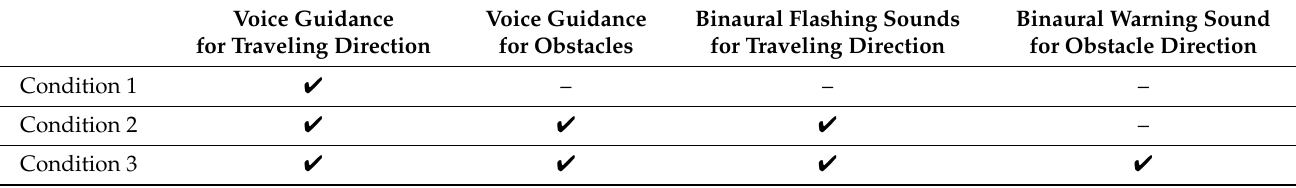
Table 9. Voice information on the direction in which to move at each of the junctions from C1 to C8.